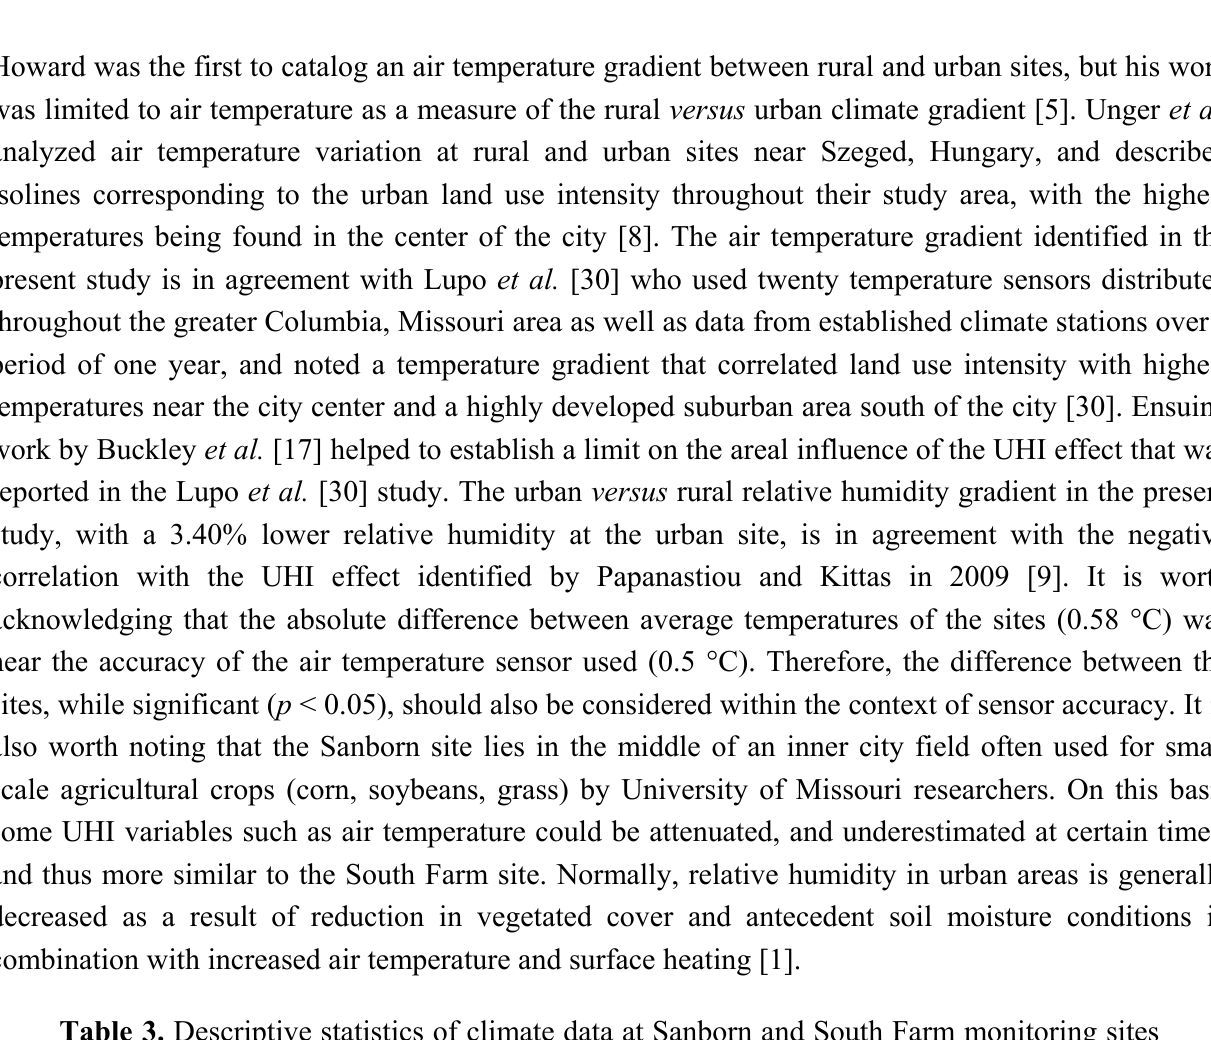
Table 3. Descriptive statistics of climate data at Sanborn and South Farm monitoring sites from 18 January 1995 to 8 October 2013, Columbia, Missouri, USA. PPT = precipitation, Ta = air temperature, RH = relative humidity, Usp = wind speed, Udir = wind direction, Rs = shortwave radiation, Ts = soil